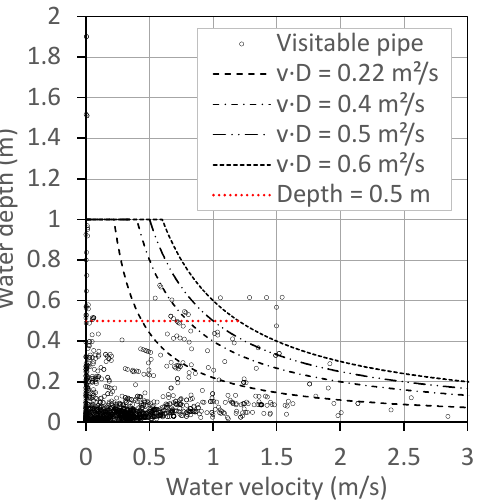
Figure 7. Hazard assessment for all the simulated visitable conduits of the urban drainage model in the scenario with maximum flow. Different v · D products and depth criteria are also